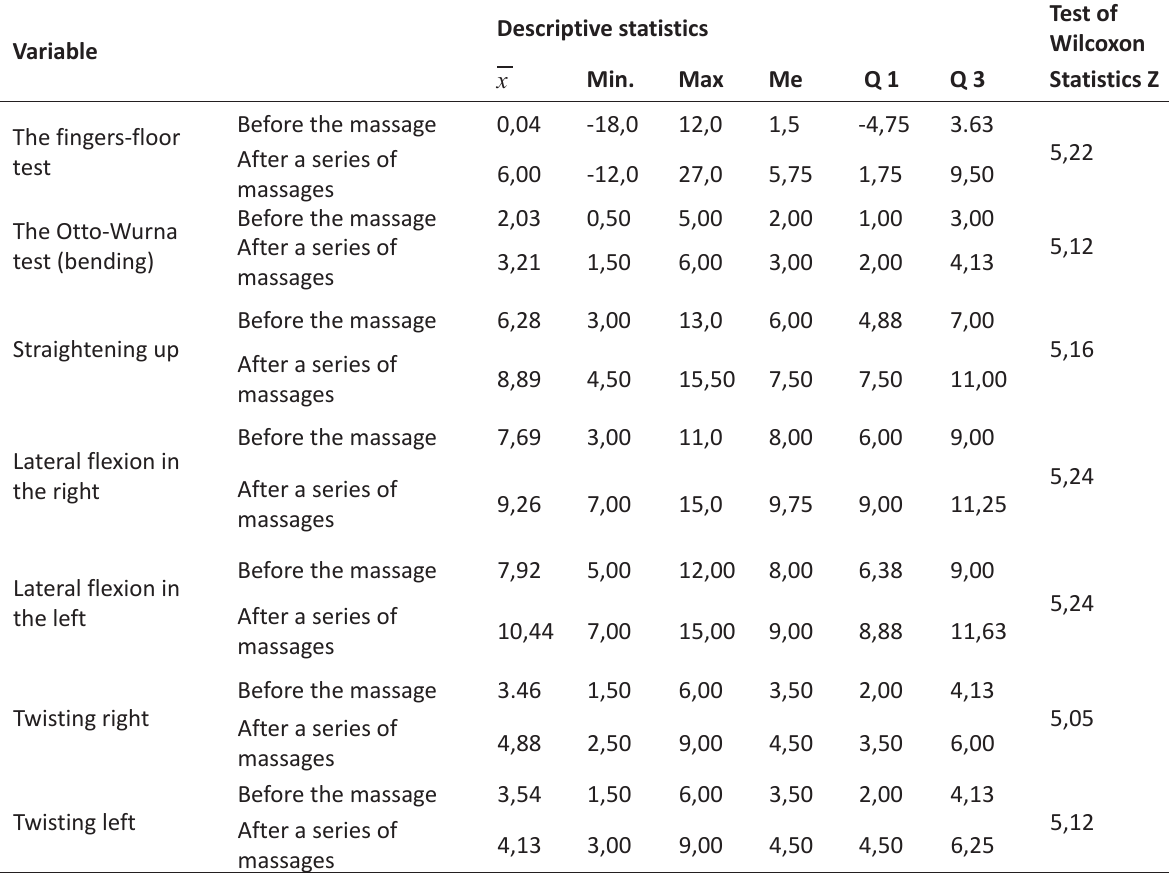
Table 1. The test statistics values and p-value obtained in the test, Wilcoxon test at significance level α = 0.05 for all variables tested before the first and after a series of massages in the whole tested